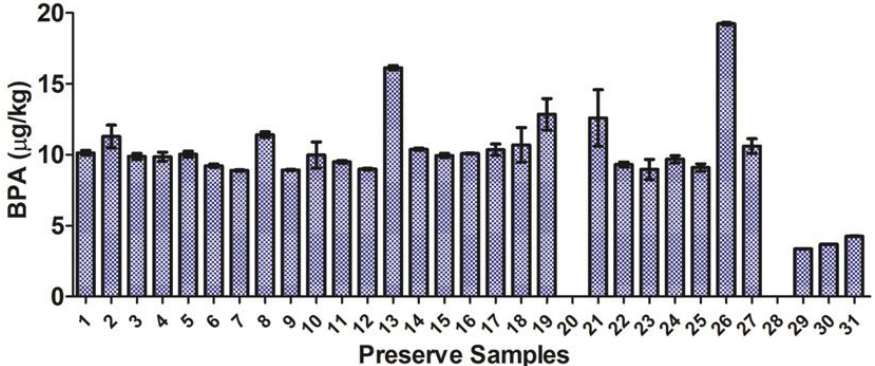
Figure 4. The concentration of bisphenol-A (BPA) in historical preserves is presented as the average ± standard deviation determined from three successive samplings of each historical preserve. These samples notwithstanding, detected BPA levels were in the range of those reported to induce endocrine disruption (e.g., antiandrogenic) effects in biochemical assays [37]. BPA levels were fairly constant over the entire sample set and over the three successive samplings of each preserve (Figure S4), consistent with reported persistence of release pathways from consumer polymers [38] and our data from resampling experiments using BPA spiked into store-bought preserves (Figure 1). Though significant differences in SPME-detected BPA burdens were detected ( p < 0.05; paired t -test), if one considers the absolute mass of BPA sampled by the SPME fiber, detected masses were considerably more uniform over the data set (Figure 4; Figure S4; Table S3). Such uniform volatilization from the preserves over lengthy successive SPME sampling periods provides potentially useful insight into human exposure risks prior to regulatory controls on BPA. Indeed, these may be the first such insights available in the literature. Using spiked BPA uptake data, we estimated naturally incurred BPA burdens (presumed to have leached from the protective plastic lid liners during storage) to be of the order of 1000 μg sample -1 . This estimate is within the range of measured concentrations of BPA leached from consumer bottles lined with epoxy resin-based protective coatings [39]. The absolute mass of spiked BPA sampled by the SPME fiber over the entire sample set was calculated to be 2.5 ± 0.2% of the total spiking mass (1000 μg ), which is consistent with BPA’s low vapor pressure and the Henry’s Law